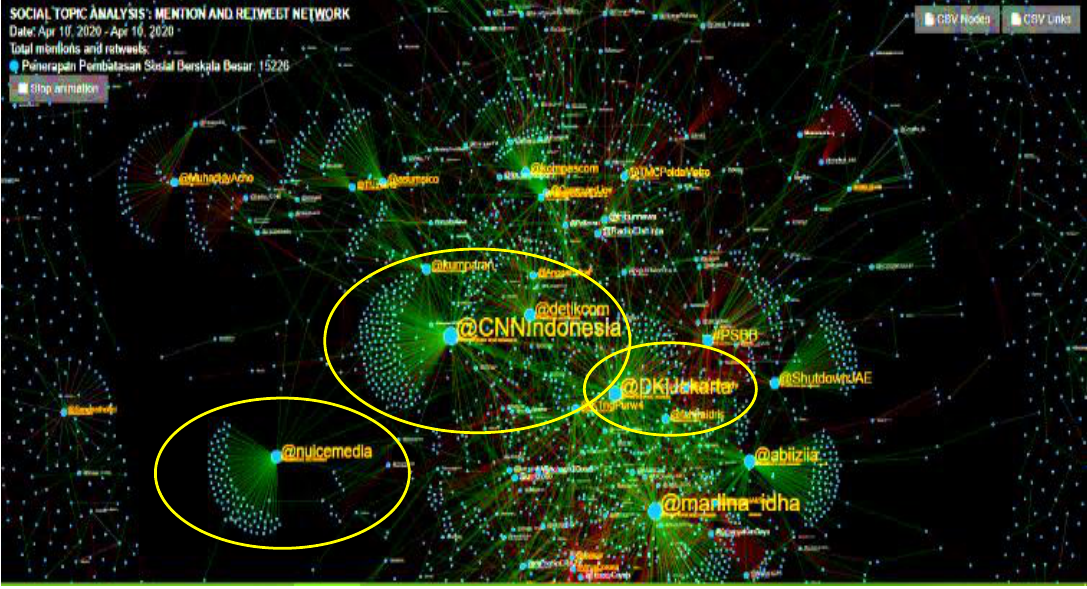
Figure 5. Social network analysis on the first day of LSSR on 10 April 2020; the condition was recorded at 11:59 p.m.